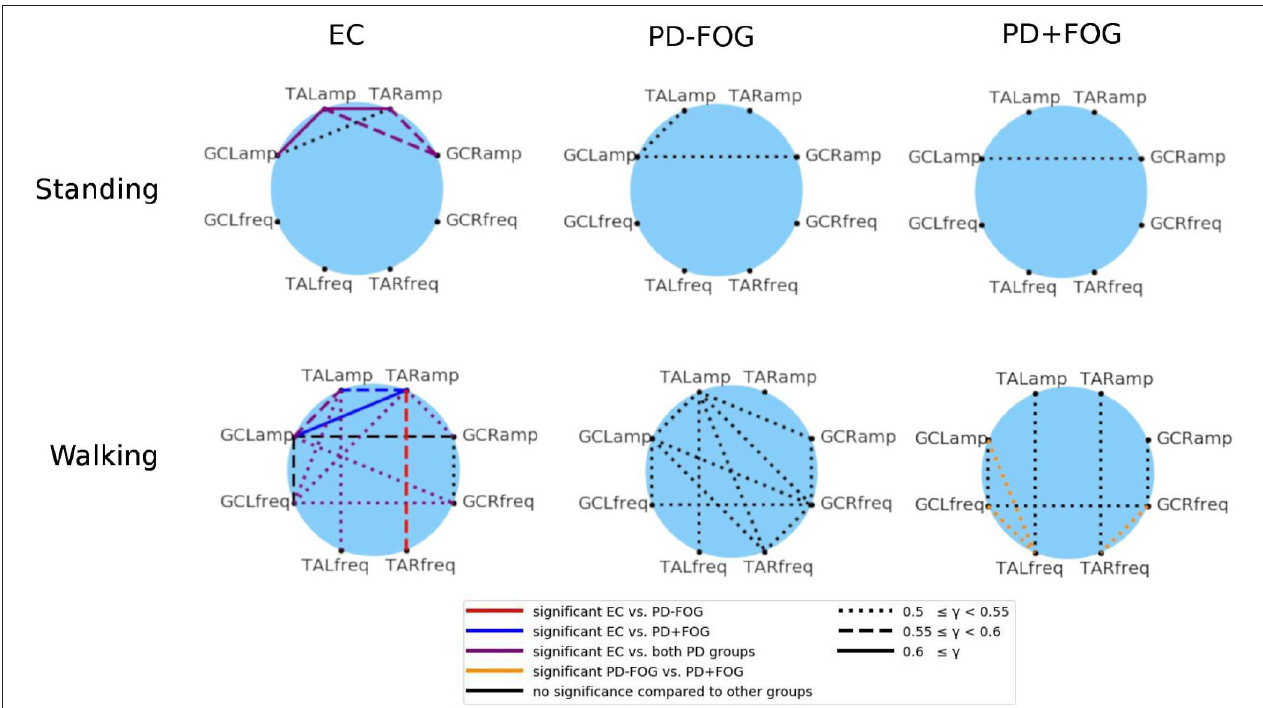
FIGURE 3 | (Color online) Network representation of phase synchronization between EMG-derived amplitudes (four nodes in the top half of each circle, both legs and both muscles) and EMG-derived frequencies (four nodes in the bottom half of each circle). A link is plotted if the corresponding average value of the synchronization index γ (see Equation 2) exceeds an ad-hoc limit of 0.5. The link strength is indicated by different line styles (see figure legend): (i) dotted line for 0.5 ≤ γ j , k < 0.55, (ii) dashed line for 0.55 ≤ γ j , k < 0.6, and (iii) solid line for γ j , k ≥ 0.6. The six network plots show group averages for EC (left), PD-FOG (center), and PD+FOG (right) groups; the top panel is for a standing still trial and the bottom panel for figure-eight walking. It is interesting to note that for both PD groups during still standing there is a coupling between EMG amplitudes of GC which is absent in EC subjects. During walking, the amplitude-frequency synchronization increases for all groups, and is most pronounced for EC and much smaller for PD + FOG. Also, PD + FOG subjects show very weak synchronization between right and left leg. Statistically significant links are marked by the following colors (figure legend): (i) in the EC networks - red = links that are significant only for the EC to PD-FOG comparison, dark blue = links that are significant only for the EC to PD + FOG comparison, violet = links that are significant for both comparisons; (ii) in the PD + FOG networks: orange = links that are significant for the PD-FOG to PD + FOG comparison. Significance was probed performing Student’s t -tests and the significance level was set to p < 0.05. TA, musculus tibialis anterior; GC, musculus gastrocnemius; R, right leg; L, left leg; amp, EMG amplitude signal; freq, EMG frequency